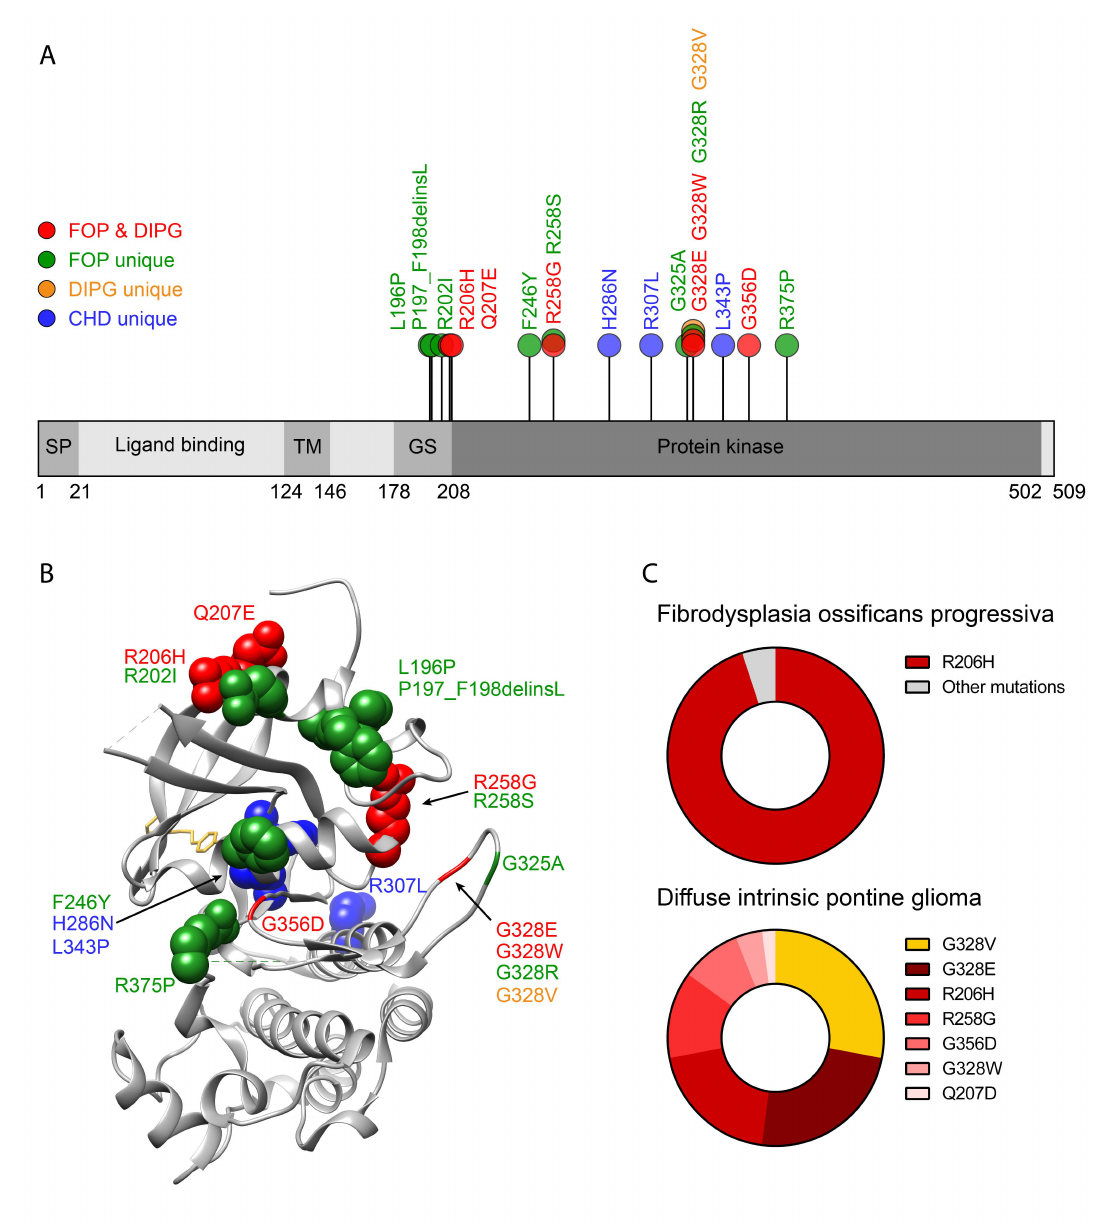
Figure 1. Distribution of recurrent ACVR1 mutations in human pathologies. ( A ) Schematic representation of ACVR1 protein and observed mutations in fibrodysplasia ossificans progressive (FOP), di ff use intrinsic pontine glioma (DIPG), and congenital heart defects (CHD). Domains depicted from amino acids 1 to 509, including signal peptide (SP), ligand-binding domain, transmembrane domain (TM), glycine-serine-rich domain (GS), and protein kinase domain. ( B ) 3D crystal structure of GS and protein kinase domains of ACVR1 protein. Secondary structure elements shown as ribbon diagram. Mutations observed in both FOP and DIPG (red), mutations only observed in FOP (green), DIPG (yellow), or CHD (blue) are labelled in each mutation site. Highlighted amino acids are represented as space-filling spheres. Dorsomorphin, a type I BMP receptor inhibitor, (yellow stick) is represented in the ATP-pocket of ACVR1 kinase. 3H9R structure was obtained from PDB [50] and visualised using UCSF Chimera software [51]. ( C ) Proportion of FOP and DIPG cases a ff ected by ACVR1